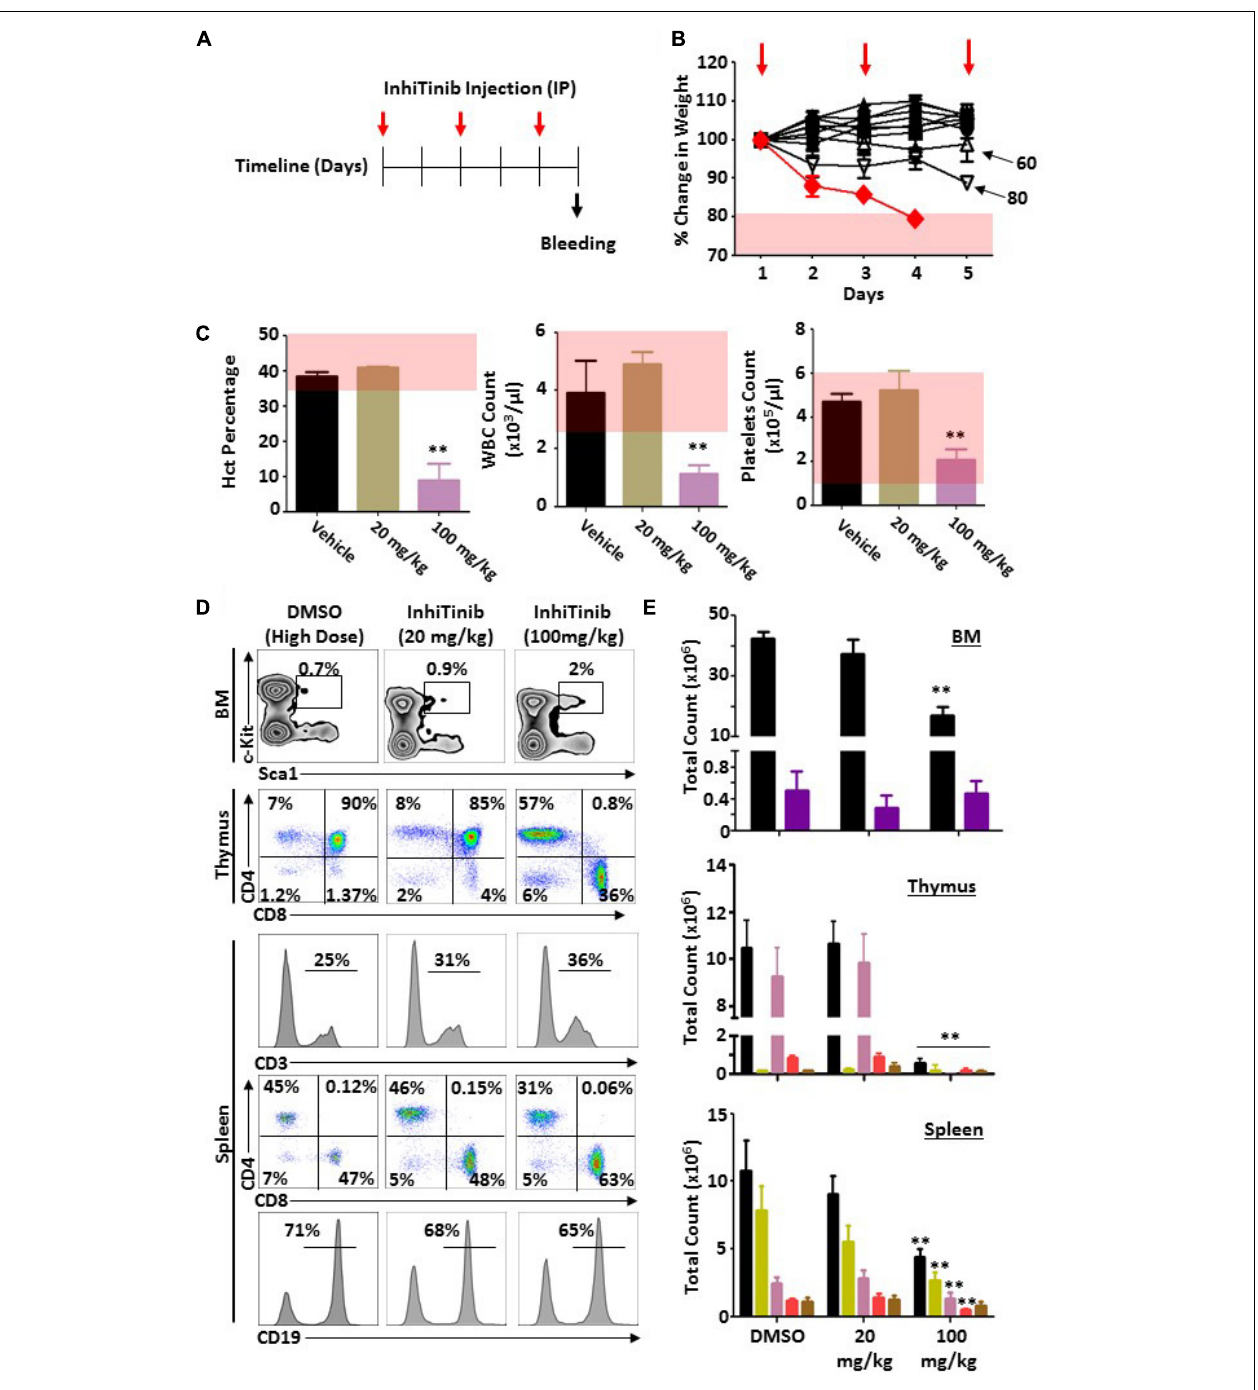
FIGURE 3 | Evaluating the safety profile of InhiTinib in immunocompetent mice. (A) Schematic diagram representing the timeline used for the toxicity study. Red arrows depict InhiTinib administration. (B) Daily assessment of weight loss in animals receiving various doses of InhiTinib. The red line represents the 100 mg/kg dose whereas the pink shaded area reflects a weight loss superior to 20% of the initial animal weight. InhiTinib is represented by the red arrows. (C) Assessment of three CBC parameters in animals treated with the vehicle, DMSO, or InhiTinib at 20 versus 100 mg/kg. The pink shaded area represents the physiological levels for each parameter. (D) Representative flow-cytometry analysis of the BM, thymic, and splenic compartments in response to DMSO and low (20 mg/kg) or high (100 mg/kg) InhiTinib doses. (E) Quantification of the various hematopoietic cells assessed in panel D. For the BM compartment, all hematopoietic cells are shown in black whereas the hematopoietic stem cells (Lin - Sca1 + c-kit + ) are in purple. For thymic analysis, overall thymocytes are shown in black, double-negative thymocytes in yellow, double-positive thymocytes in pink, CD4 + thymocytes in red, and CD8 + thymocytes in brown. For the spleen analysis, overall splenocytes are depicted in black, CD19 + B cells in yellow, CD3 + T cells in pink, CD8 + T cells in red and CD4 + T cells in brown. For panels D and E, n = 6/group with ∗∗ P < 0.01.